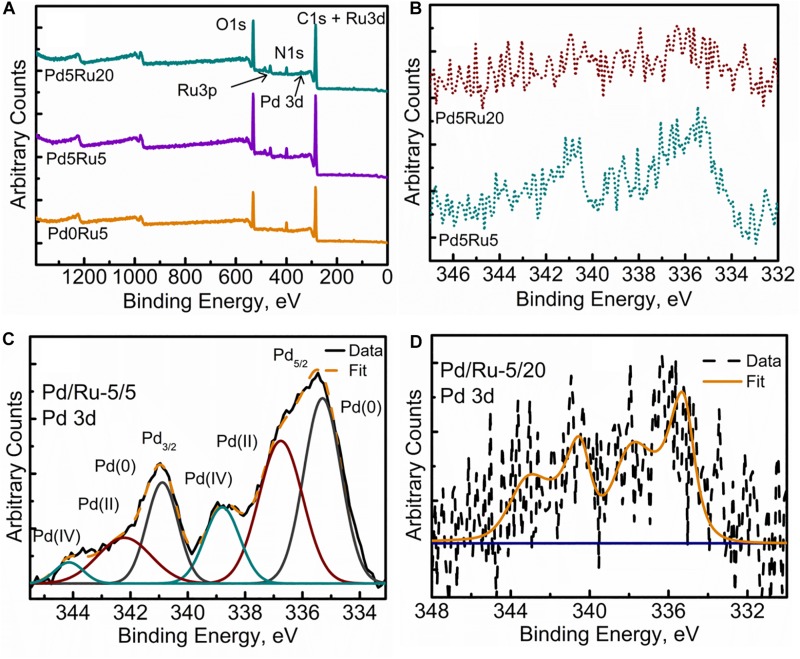
XPS spectra of (A) Wide Energy Survey Spectra (WESS) for all three samples, (B) high resolution Pd 3d spectra, and fitted components for (C) Low Pd and Ru loading sample and (D) low Pd high Ru loading sample.